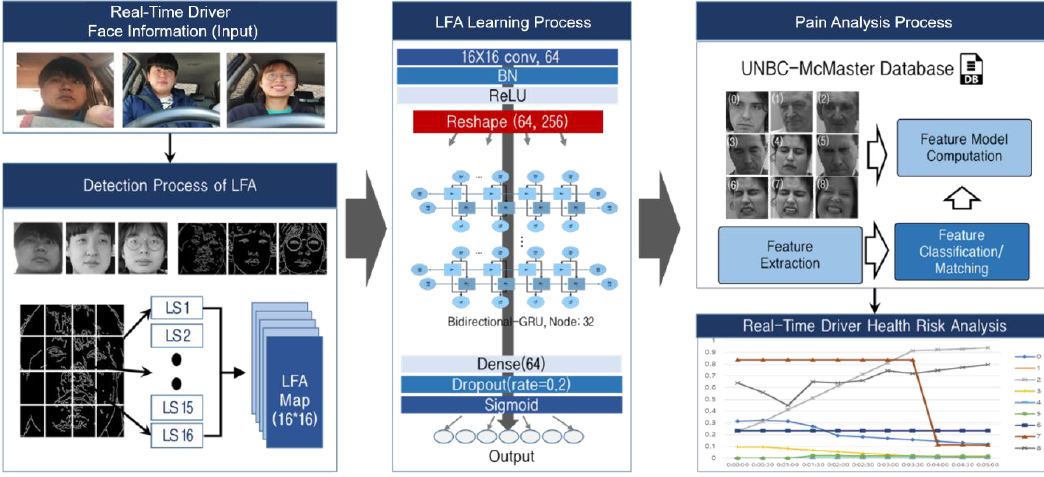
Figure 9. Driver pain status analysis process and its performance evaluation.